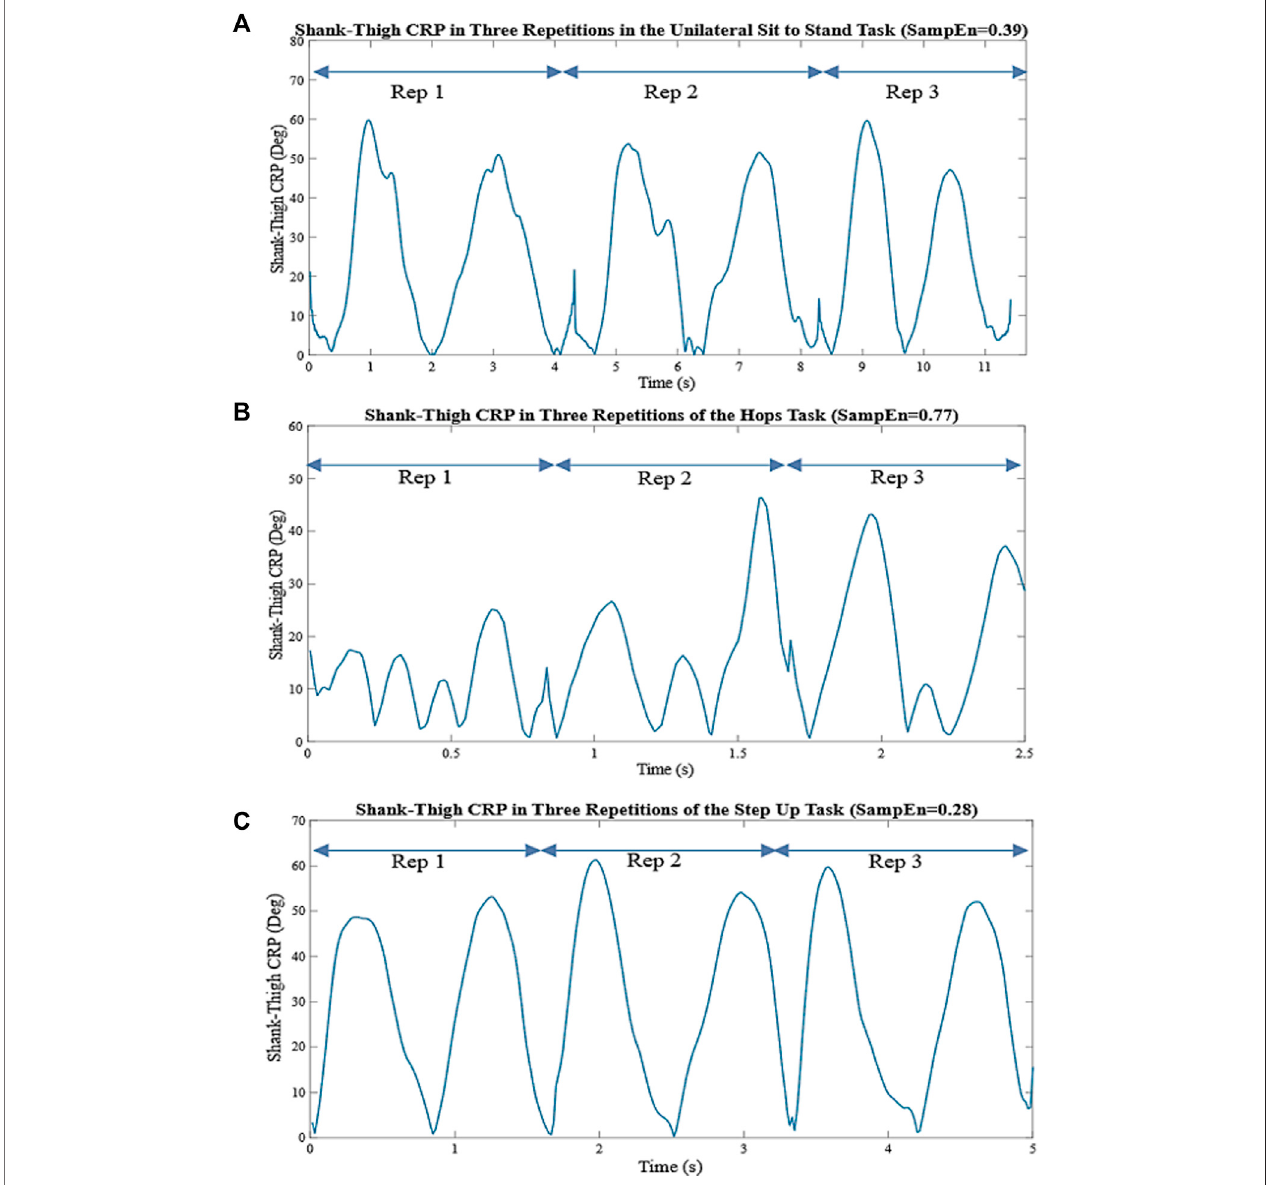
FIGURE3|(A) Shank-thigh CRPinthree repetitions oftheUniSTS. (B) Shank-thighCRPin threerepetitionsofthe Hops. (C) Shank-thigh CRPinthree repetitions of the SUs. The nonlinear coordination variability is measured by the SampEn applied to theoverall shank-thigh CRP in all repetitions. The higher SampEn isindicativeof larger interlimb coordination variability and